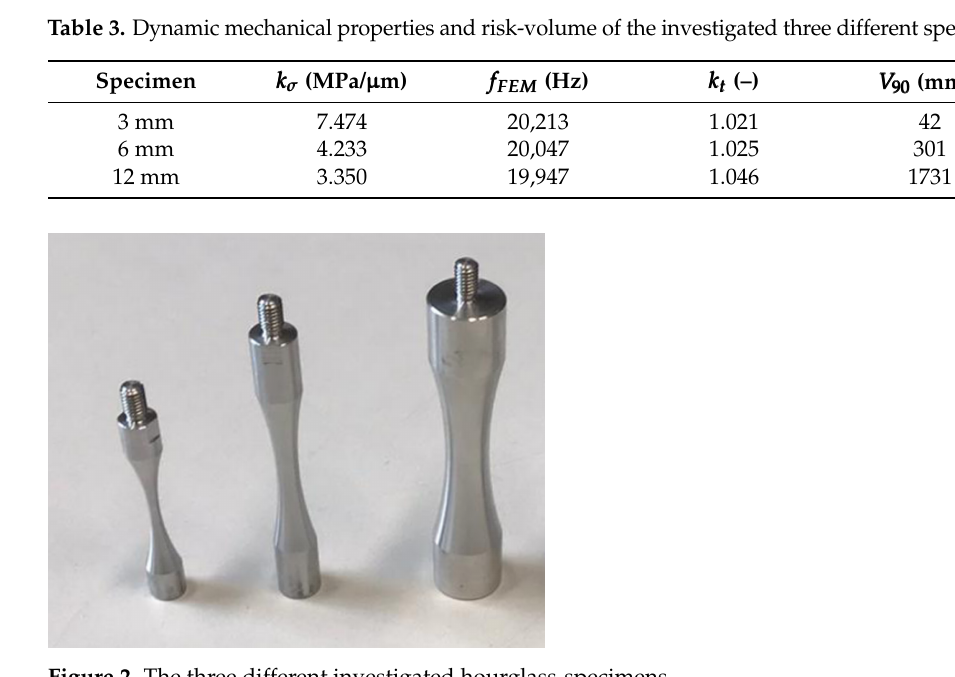
Figure 2. The three different investigated